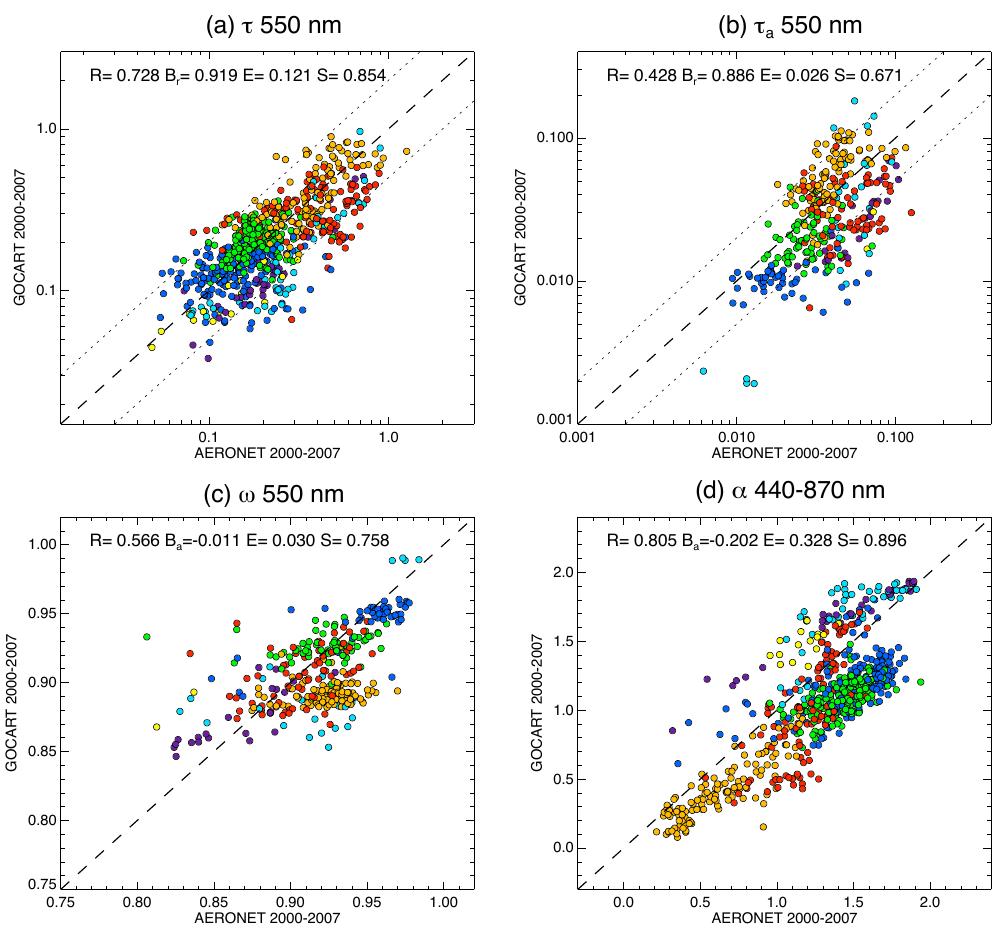
Fig. 6. Overall comparisons of τ , τ a , and ω at 550nm and α at 440–870nm between AERONET and GOCART at all 173 AERONET sites (see Fig. 3) during 2000–2007. Each point represents the annual average of the available AERONET data with a year. Model output is averaged for the same days. Points are color coded according to the regions (see Fig. 3). 1:1 ratio in dashed line and 2:1 in dotted lines on τ and τ a panels. Statistical variables on each panel are: R =correlation coefficient, B r =relative mean bias (for τ and τ a ) , B a =absolute mean bias (for ω and α ), E =root-mean-square error, and S =skill score. See text and Fig. 5a caption for